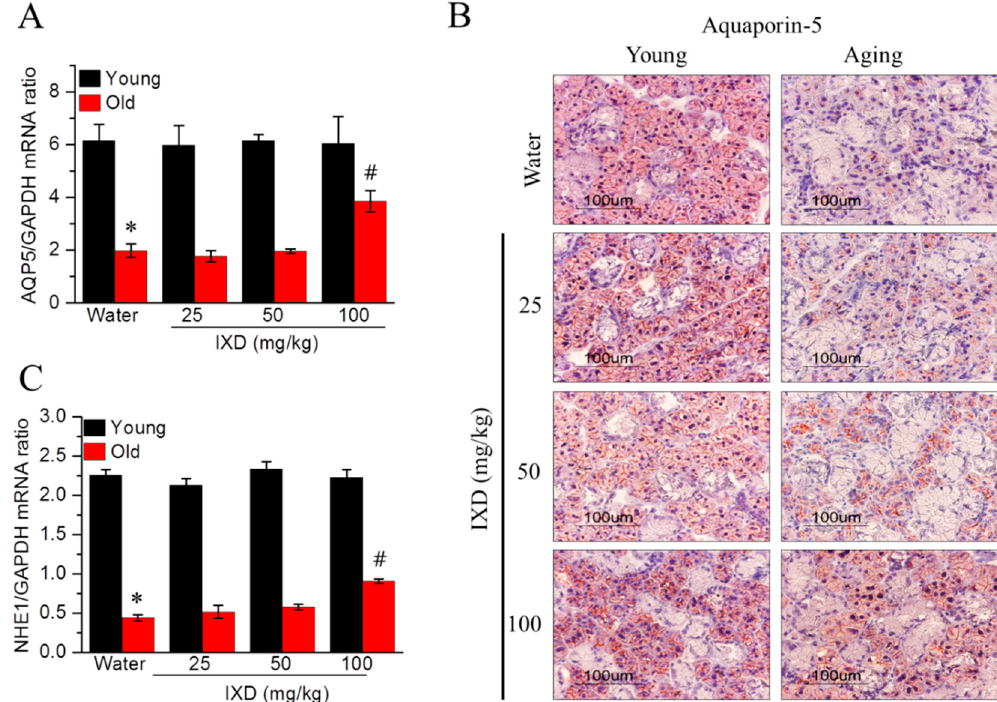
Figure 4. ( A ) Aquaporin-5 mRNA expression as evaluated by quantitative real-time PCR; ( B ) Aquaporin-5 protein expression as identified by immunostaining using the AQP5